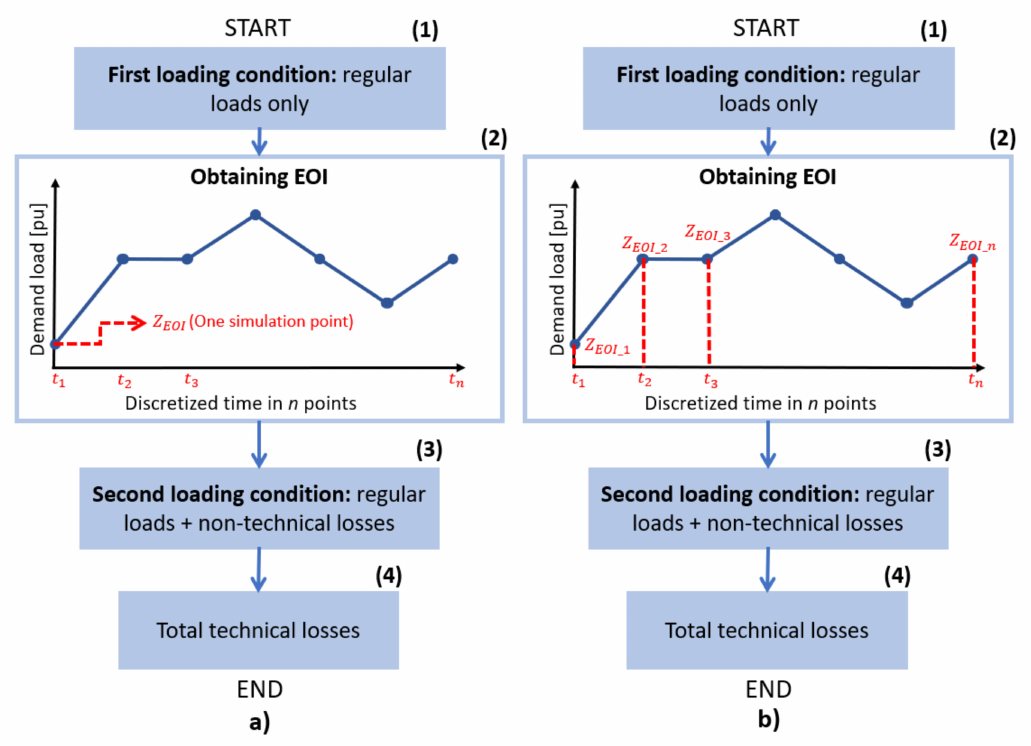
Figure 2. Methodology for applying the EOI to calculate losses. ( a ) one value of EOI and ( b ) n values of EOI, according to number of loadshape